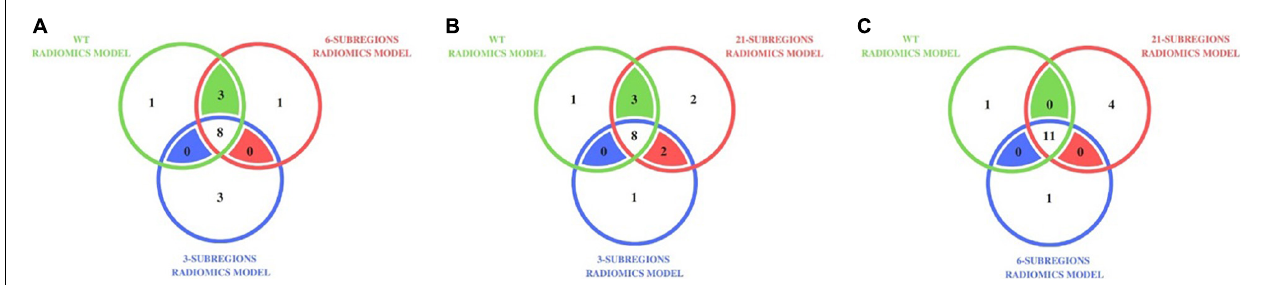
FIGURE 2 | Distribution of misclassified subjects in (A) the WT radiomics model, the 3-subregions radiomics model, and the 6-subregions radiomics model (B) the WT radiomics model, the 3-subregions radiomics model, and the 21-subregions radiomics model (C) the WT radiomics model, the 6-subregions radiomics model, and the 21-subregions radiomics model, on testing cohort A (31 subjects). For instance, 11 subjects were misclassified by the WT , 6-subregions , and 21-subregions radiomics models. TABLE 6 | Quantitative analysis of four radiomic models, namely, the WT radiomics model, the 3-subregions radiomics model, the 6-subregions radiomics model, and the 21-subregions radiomics model, on testing cohort B (29 subjects). Segmentation network Accuracy (%) WT 3-Subregions radiomics model radiomics